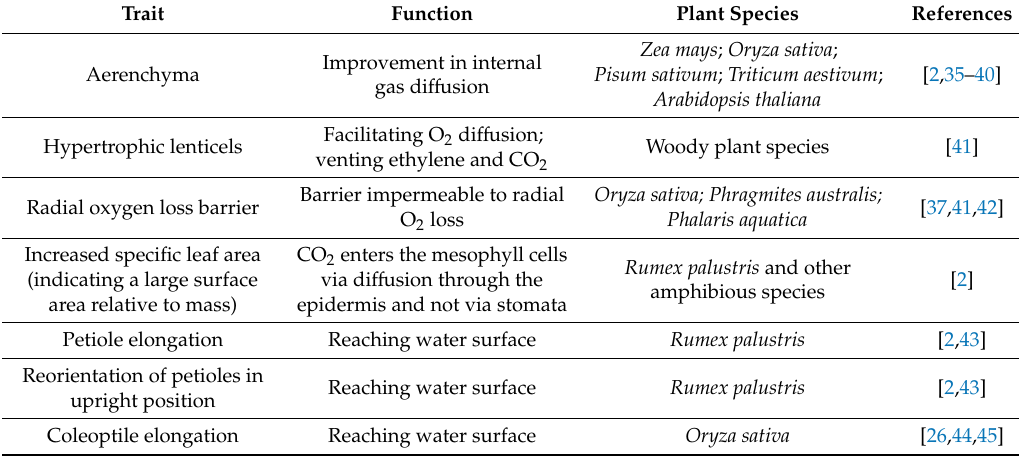
Table 1. Traits affected by waterlogging and submergence in plants.